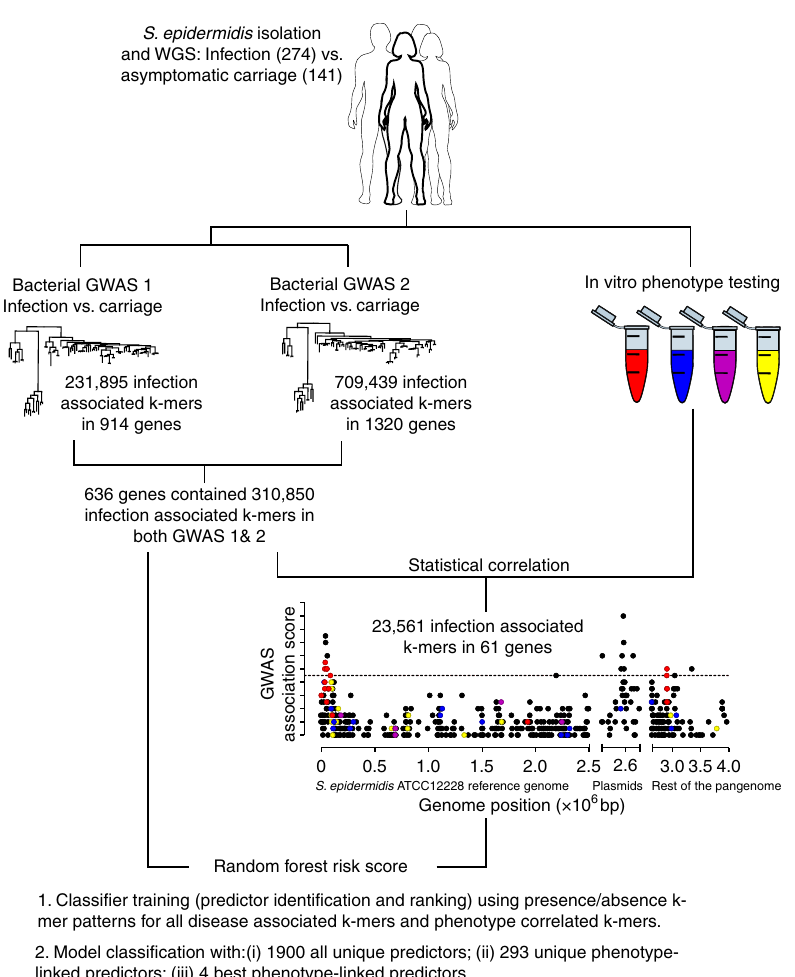
Fig. 1 Phenotype correlated GWAS and risk prediction. Genome-wide association studies (GWAS) can identify numerous SNPs associated with complex traits but these can be dif fi cult to interpret. For example, pathogenicity is multifactorial, potentially involving genes underlying phenotypes that promote transmission, virulence, immune evasion, antimicrobial resistance etc. In some bacteria, speci fi c phenotypes known to contribute to pathogenicity can be measured in laboratory assays, providing a basis for quantitative analysis of disease dynamics. We developed a method in which k-mers from a primary GWAS analysis (asymptomatic carriage vs. infection isolates) were correlated with data from four relevant phenotype assays: bio fi lm formation (blue); cell toxicity (yellow); methicillin resistance (red); IL-8 production by host cells (purple). Using Fisher ’ s exact test, k-mers from primary GWAS were correlated with laboratory phenotype using a 2 × 2 table in which rows indicated presence/absence of the k-mer and columns indicated upper and lower percentile in the laboratory phenotype assay. The resulting P -values, derived for each k-mer, help to link k-mers in the primary GWAS with quanti fi able pathogenicity- related phenotypes. Patterns of k-mer presence and absence can be used as classi fi ers in a random forest model to identify the best predictors of